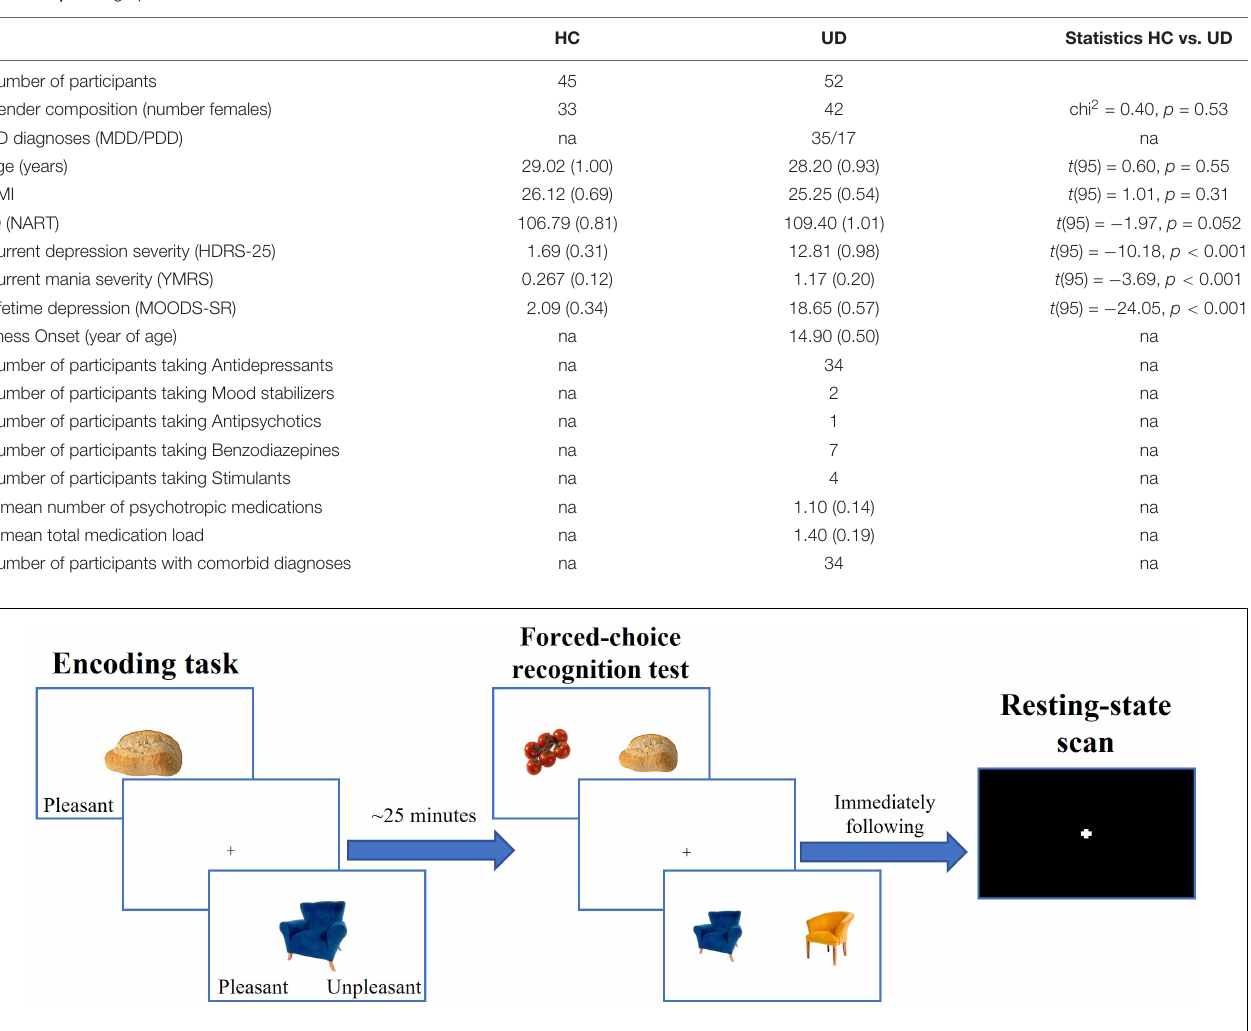
TABLE 1 | Demographic and clinical characteristics.